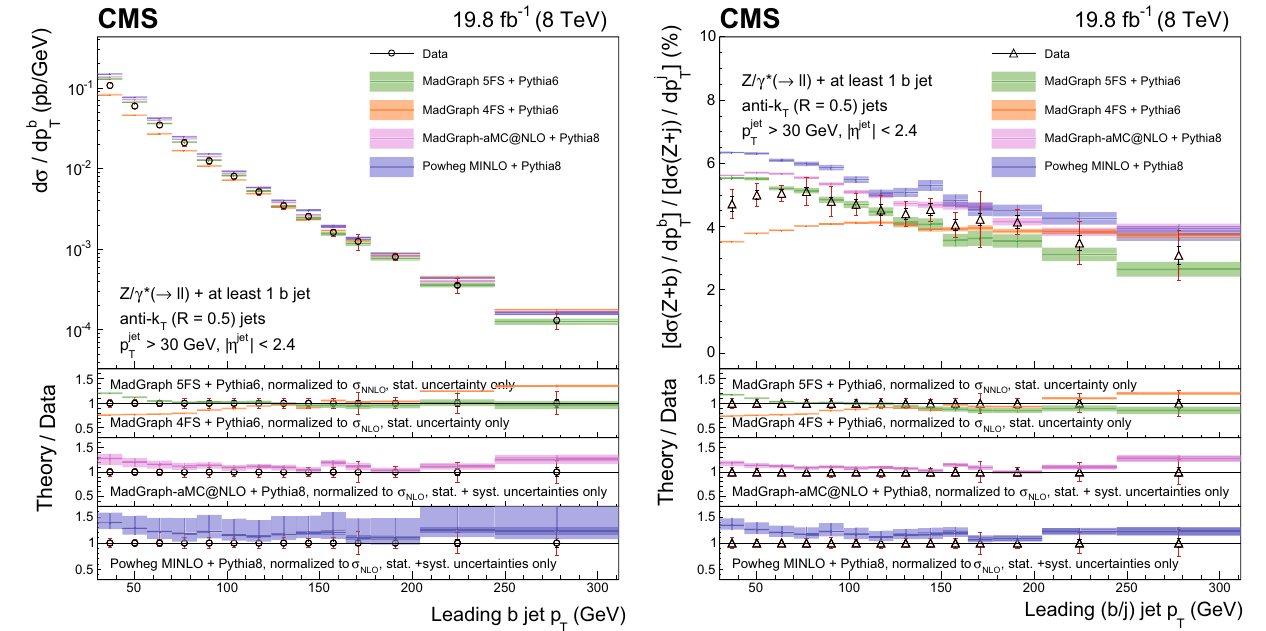
Fig. 4 Differential fiducial cross section for Z(1b) production as a function of the leading b jet p T ( left ), and the cross section ratio for Z(1b) and Z+jets production as a function of the leading b/inclusive (j) jet p T ( right ), compared with the MadGraph 5FS, MadGraph 4FS, MadGraph5 _a MC@NLO ,and powhegminlo theoreticalpredictions ( shaded bands ), normalized to the theoretical cross sections described